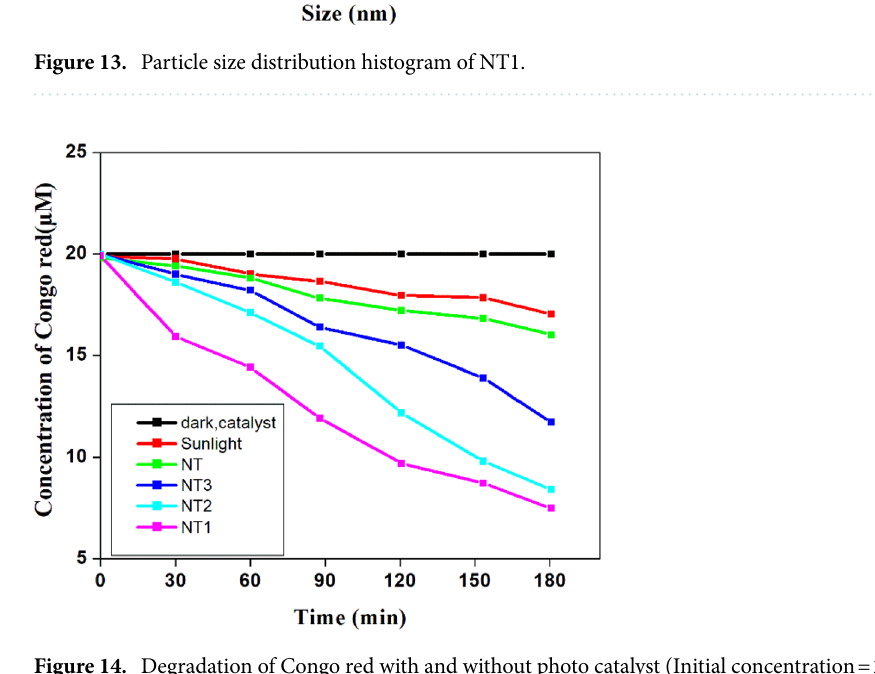
crystalline grain with single spaced lattice rows were free from defects found to be coherent with X-ray diffrac- tion analysis results 56 . Photo catalytic studies. The photo catalytic efficiency of the synthesized sample was verified against Congo red, a textile dye, by irradiating 100 ml of dye solution containing specific quantity of templated NT samples under sunlight during 12 noon to 1 pm in the month of June. The intensity of sunlight was monitored using digital lux meter (HTC make Digital Lux meter, model LX-101A). The change in concentration of Congo red during the process of photo degradation was followed using UV–Vis Spectro photometer (Lambda 35, Perkin Elmer) at its absorbance maximum of 497 nm. Photo catalytic efficiency of synthesized titania samples. The efficiency of the photo catalysts thus derived are evaluated from the photo degradation of Congo red in the presence of Sun light and the results are shown in the Fig. 14. The photo degradation was effective only with the irradiated titania samples compared to direct photolysis and in the dark. It is shown that green calcined titania samples were 5–10% more effective than the samples without an organic template. The photo catalytic ability of the irradiated titania samples for the degrada- tion of 20 µM Congo red was in the following order: NT1 > NT2 > NT3 > NT. It can be seen that NT1 calcined at 400 °C with the surface area of 98.6 m 2 g −1 and an average crystallite size of 18 nm with moderate agglomeration displayed maximum photo catalytic efficiency (97.4) for the degradation Congo red. It is very interesting to note that the photo catalytic ability of NT2 (96.5%) is almost at par with NT1 inspite of low surface area and high